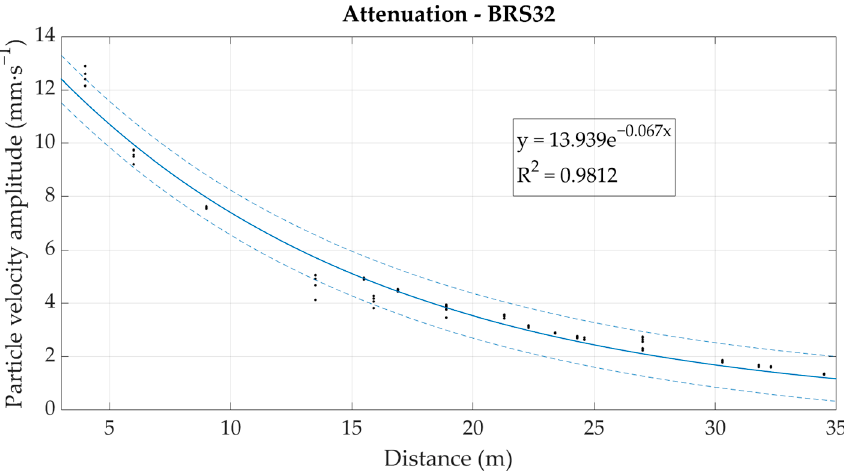
Figure 12. Graphical representation of the environmental attenuation from the values measured by seismic station BRS32.